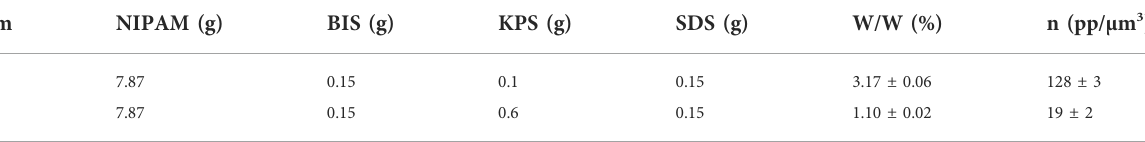
TABLE 1 Reactants used in synthesizing 500 ml of PNIPAM microgel dispersion, the weight fraction, and the particle number density of the resulting stock microgel dispersions. System